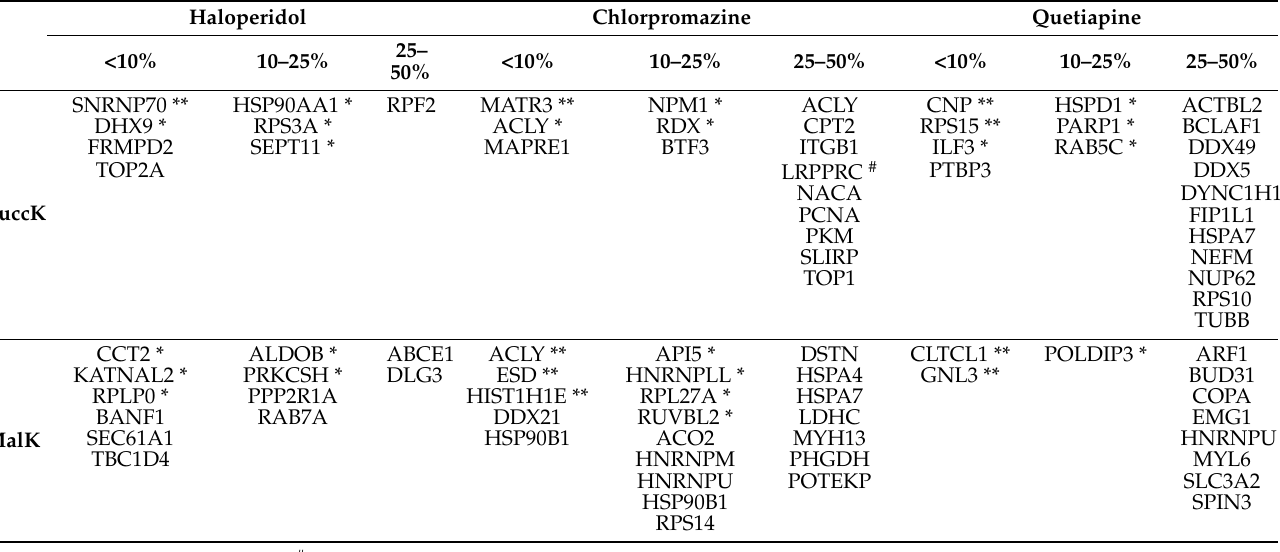
Table 1. Sites of succinylation (SuccK) and malonylation (MalK) deregulated by MK-801 (dizocilpine; 4 h) and attenuated by haloperidol, chlorpromazine, and quetiapine (co-exposure, 4 additional hours). Attenuation was classified by a return to under ± 10%, ± 25%, and ± 50% of control levels after dys- regulation past that threshold. Proteins marked with asterisks exhibited sites that were dysregulated past one (*) or two (**) additional thresholds before attenuation. All genes are represented by their UniProt gene